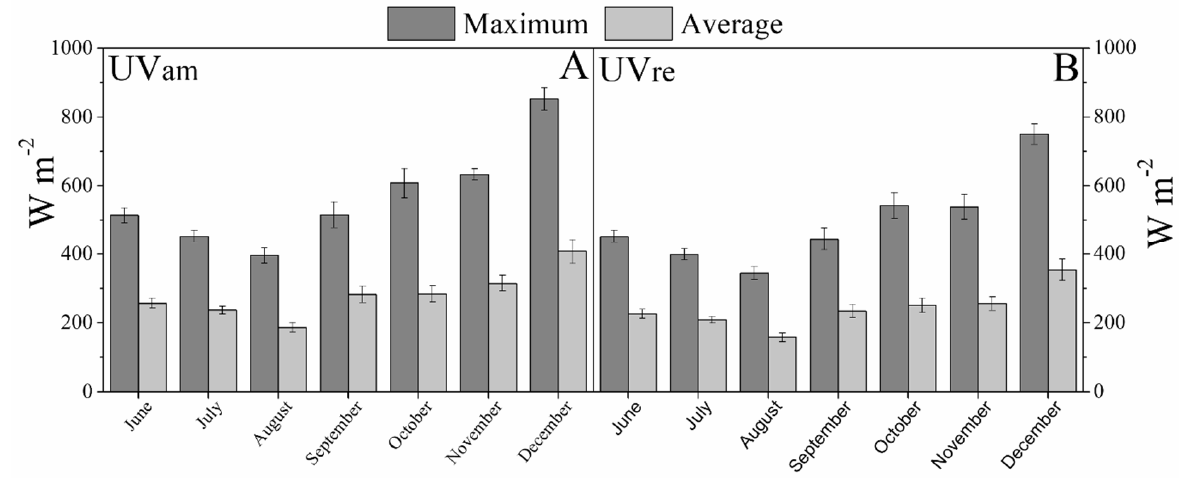
Figure 1. Diurnal maximum and average photosynthetic active radiation (PAR, W m −2 ) calculated each month, registered from June to December 2018 in either: ( A ) Near ambient (UVam) or ( B ) reduced (UVre) UV conditions.